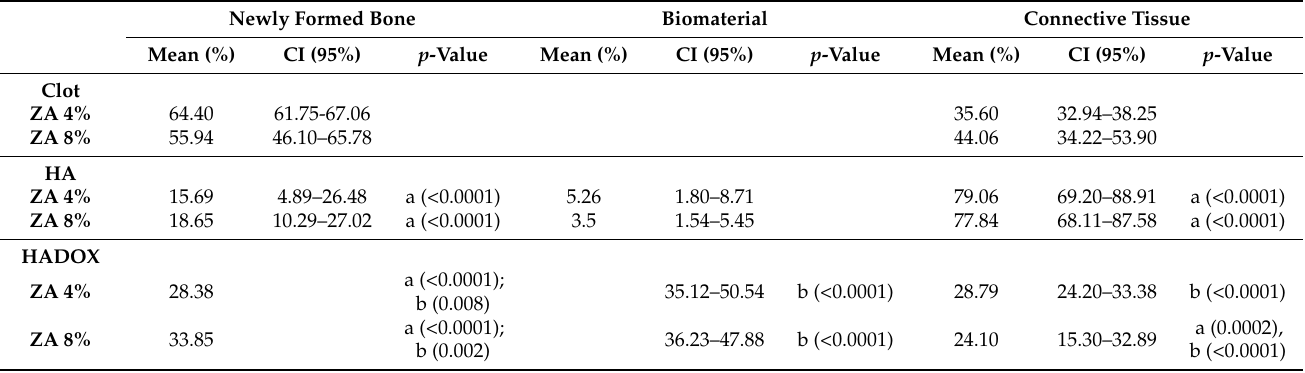
Figure 8. Newly formed bone in HA and HADOX groups treated with 4% and 8% ZA. The values are presented as mean ± C.I. The statistical differences between the groups in the same ZA treatment are represented by horizontal bars. There were no statistical differences ( p > 0.05) between 4% and 8% ZA treatment in the HA and HADOX groups (no difference is represented by the same letter) (Student’s t -test, p > 0.05). Table 1. Summary of the result findings. Mean%, confidence interval (CI) and p values of newly formed bone, remaining biomaterial and connective tissue parameters in Sham (clot), HA and HADOX groups. Statistical difference comparing clot groups with the same ZA (%). Statistical difference comparing HA groups with the same ZA